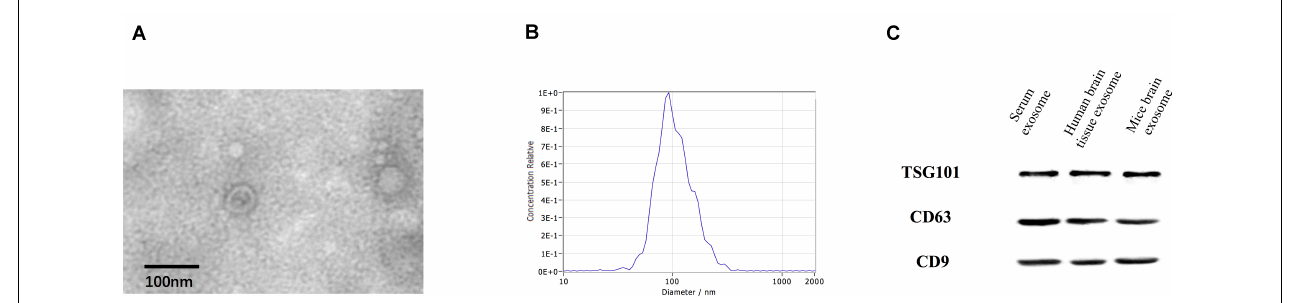
FIGURE 1 | Identification of exosomes. Characterization of exosome-like vesicles by (A) transmission electron microscopy, (B) nanoparticle-tracking analysis (140 ± 19.1 nm) and (C) Western blotting. Presence of the exosomal markers TSG101, CD63, and